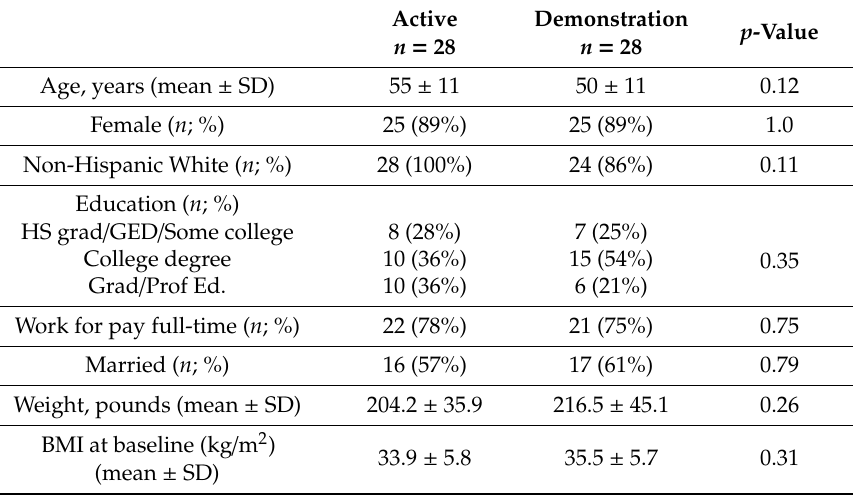
Figure 1. Consort flow diagram. Table 1. Baseline characteristics of participants.